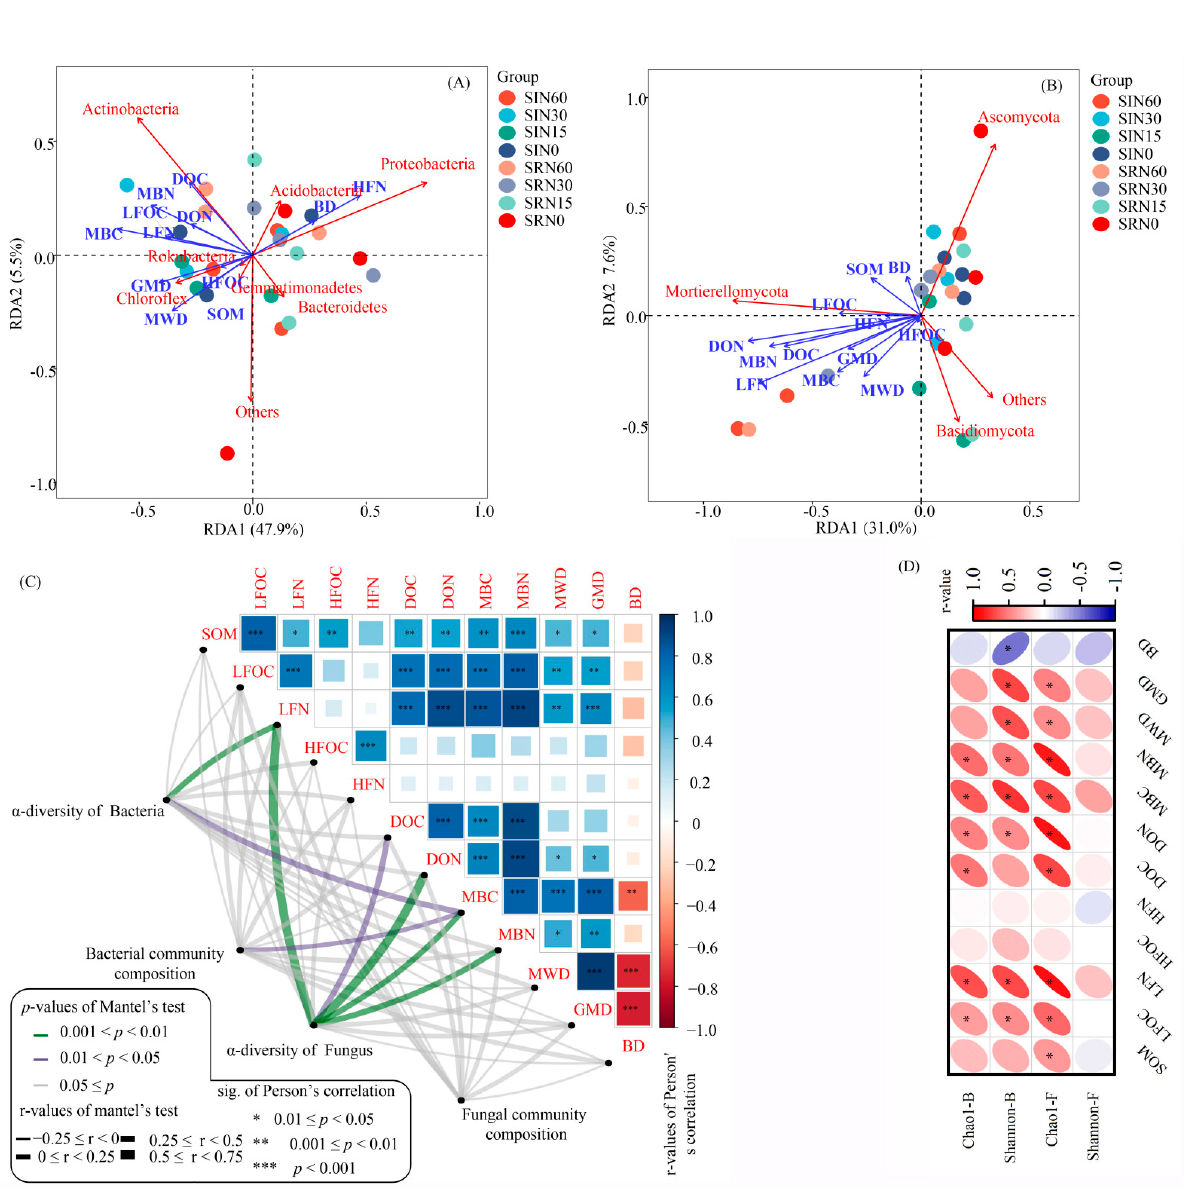
Figure 10. Relationship between the soil environmental factors and soil microbial community. ( A ) Redundancy analysis of the dominant soil bacteria phyla and soil physicochemical properties; ( B ) Redundancy analysis of the dominant soil fungi phyla and soil physicochemical properties; ( C ) Mantel test. Pairwise comparisons of environmental factors are shown, with a color gradient denoted by Pearson correlation coefficients. The soil microbial α -diversity (based on the Chao1 and Shannon index) and community composition (based on the dominant microbial phyla) were related to each environmental factor by the Mantel test. Lines width denoted the Mantel r values, and lines color denoted the statistical significance. The asterisks “*”, “**”, and “***” indicated significant differences in Pearson correlation coefficient at 0.01 ≤ p < 0.05, 0.001 ≤ p < 0.01, and p < 0.001, respectively; ( D ) Pearson correlation analysis between soil physicochemical properties and soil microbial community α -diversity. The asterisk “*” indicates a significant correlation ( p < 0.05); Chao1-B, soil bacterial richness (Chao1 index); Shannon-B, bacterial richness (Shannon index); Chao1-F, soil fungal richness (Chao1 index); Shannon-F, soil fungal richness (Shannon index); SOM, soil organic matter; LFOC, light fraction organic carbon; LFN, light fraction nitrogen; HFOC, heavy fraction organic carbon; HFN, heavy fraction nitrogen; DOC, dissolved organic carbon; DON, dissolved organic nitrogen; MBC, microbial biomass carbon; MBN, microbial biomass nitrogen; MWD, mean weight diameter of soil macroaggregates; GWD, geometry mean diameter of soil macroaggregates; BD, bulk